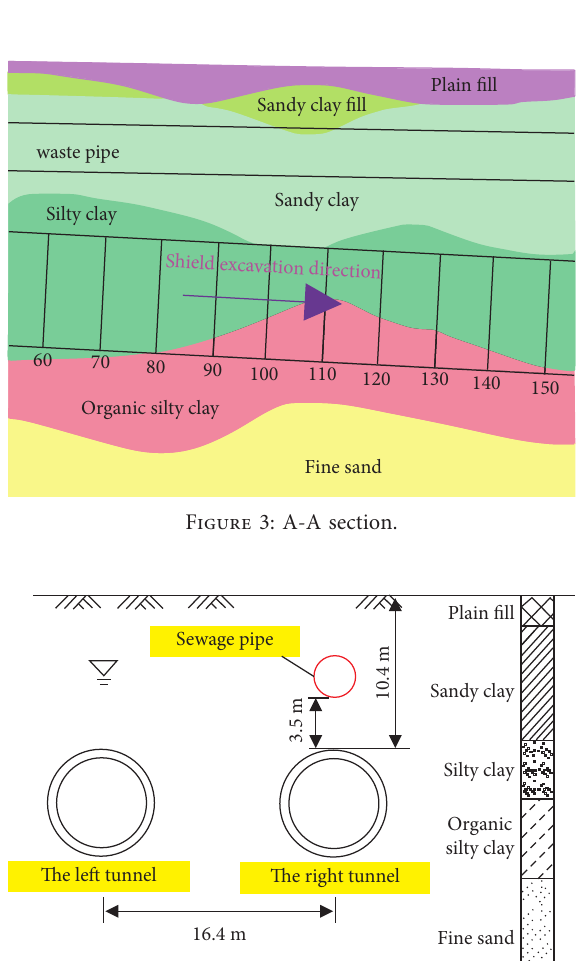
Figure 2: Shield line detail.